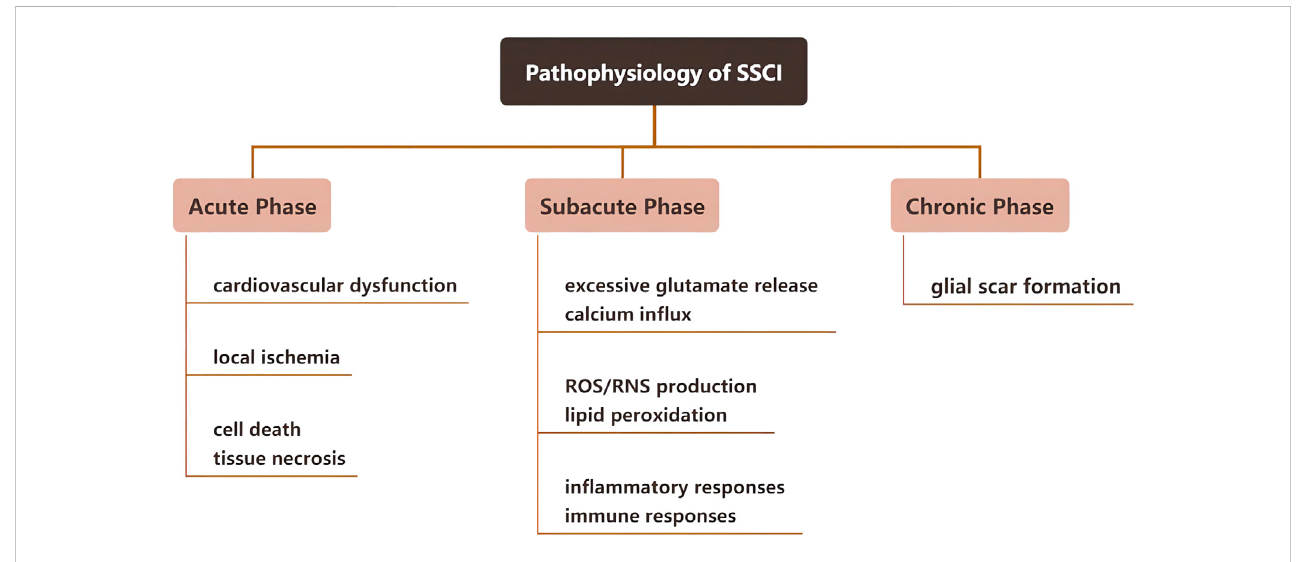
FIGURE 2 Pathophysiology, clinical manifestations, and phases of secondary spinal cord